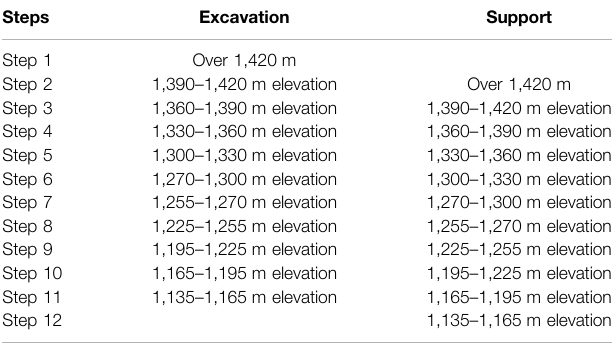
TABLE 2 | Excavation and support procedure of high slope on the left